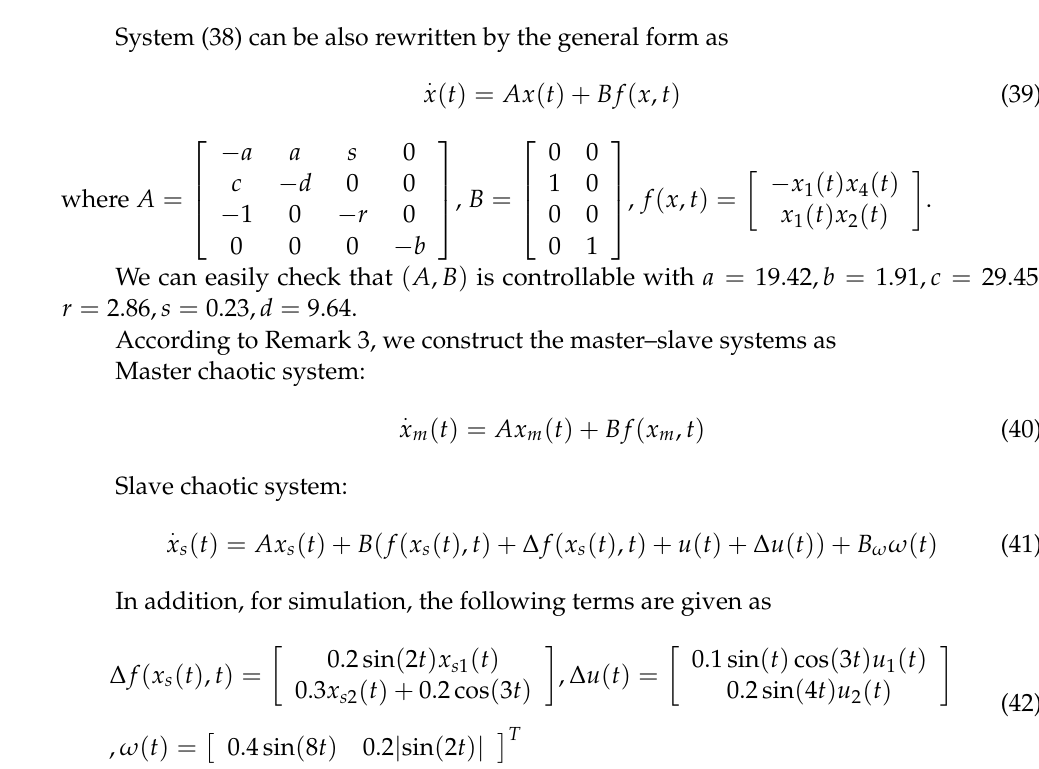
Figure 5. Chaotic strange attractor of generalized Lorenz–Stenflo system.